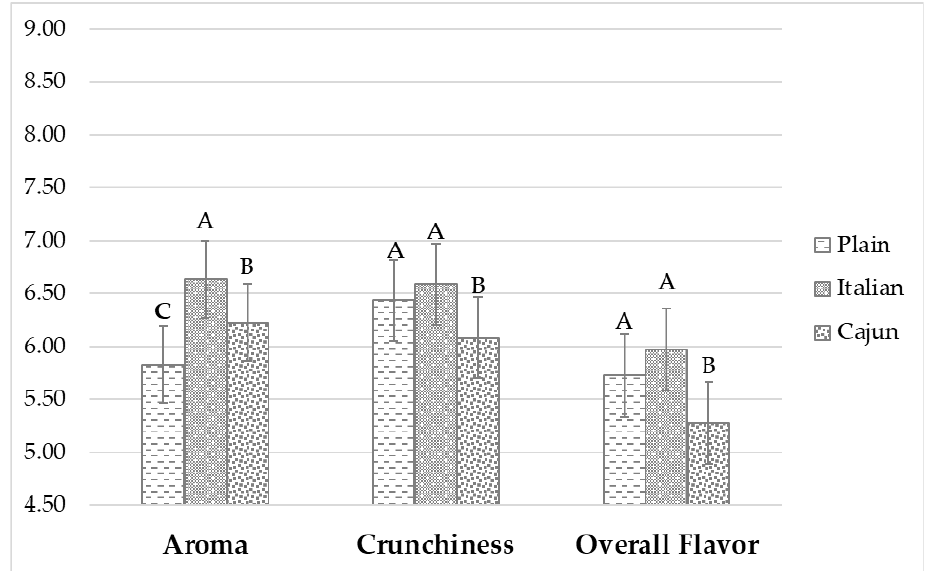
Figure 2. Treatments’ sensory acceptability bar chart for the before-tasting (aroma) and after-tasting (before edible cricket protein (ECP) statement) moments (crunchiness and overall flavor). Data are liking ratings least square means and standard errors from n = 84 consumers. Treatments are described in Figure 1. Different uppercase letters indicate significantly ( p < 0.05) different liking scores (Tukey’s means separation) across treatments.